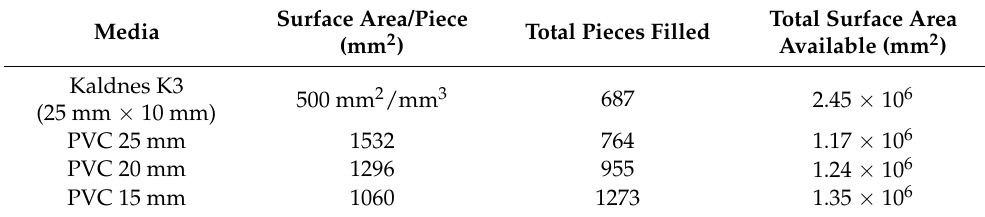
Table 1. Surface area of filter media used in the study.